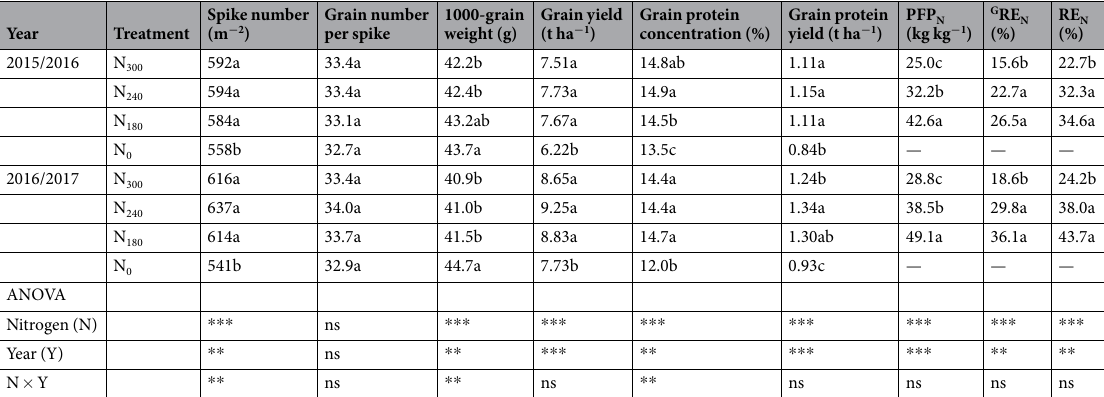
Table 3. Yield components, yield, grain protein yield and N utilization of wheat under different N treatments in 2015/2016 and 2016/2017. N